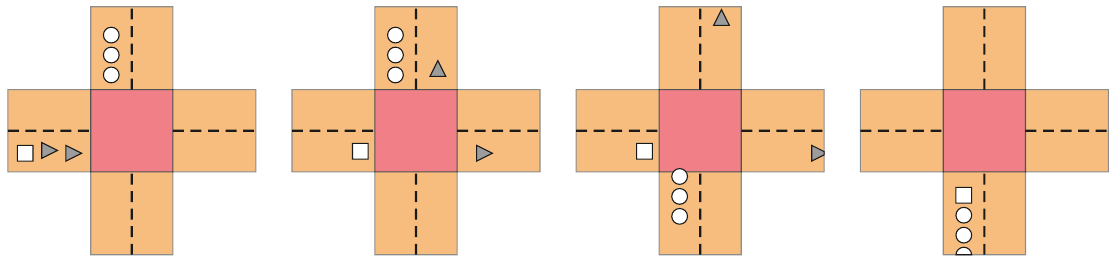
Figure 5. Join maneuver coordinated by the VTL